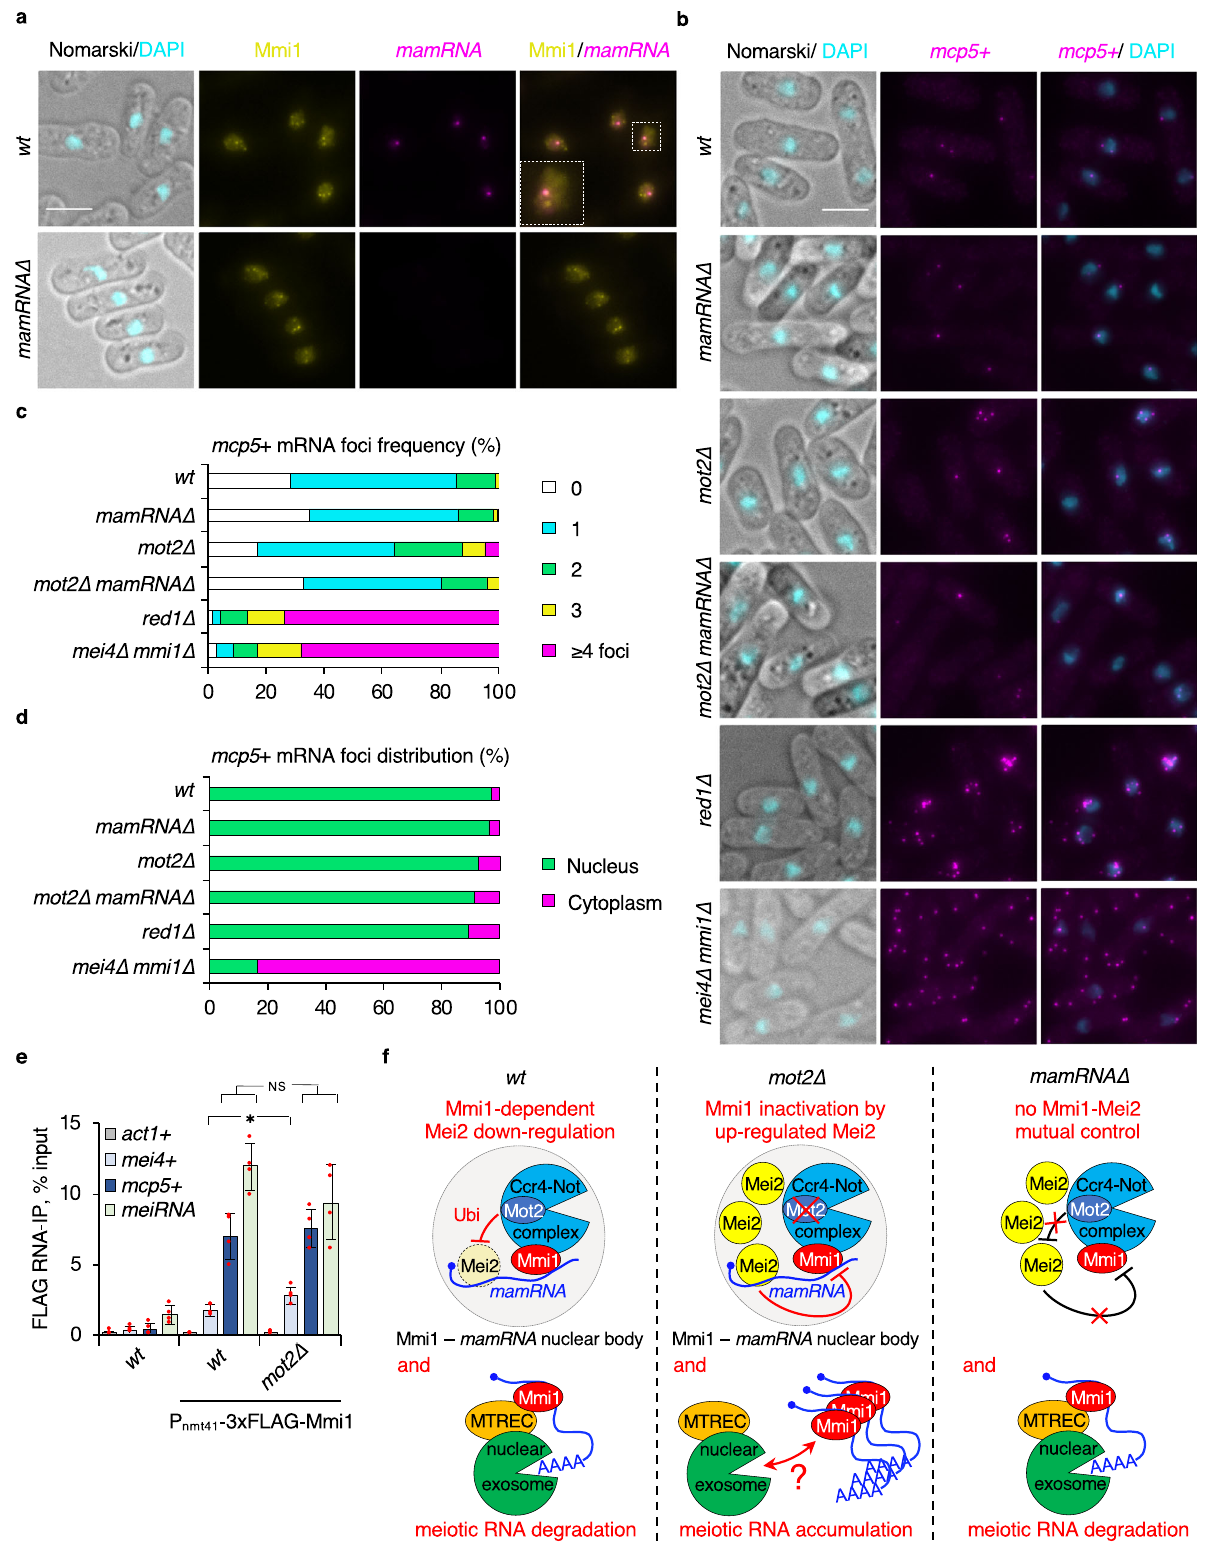
Mmi1 and Mei2, accumulates at its genomic locus to promote pairing of homologous chromosomes during meiosis, similar to meiRNA 53,54 . Whether mamRNA also contributes to this process remains an open question. Likewise, although the role of omt3 in mitotic cells remains unclear, it is tempting to speculate that another Mmi1 body lies at this